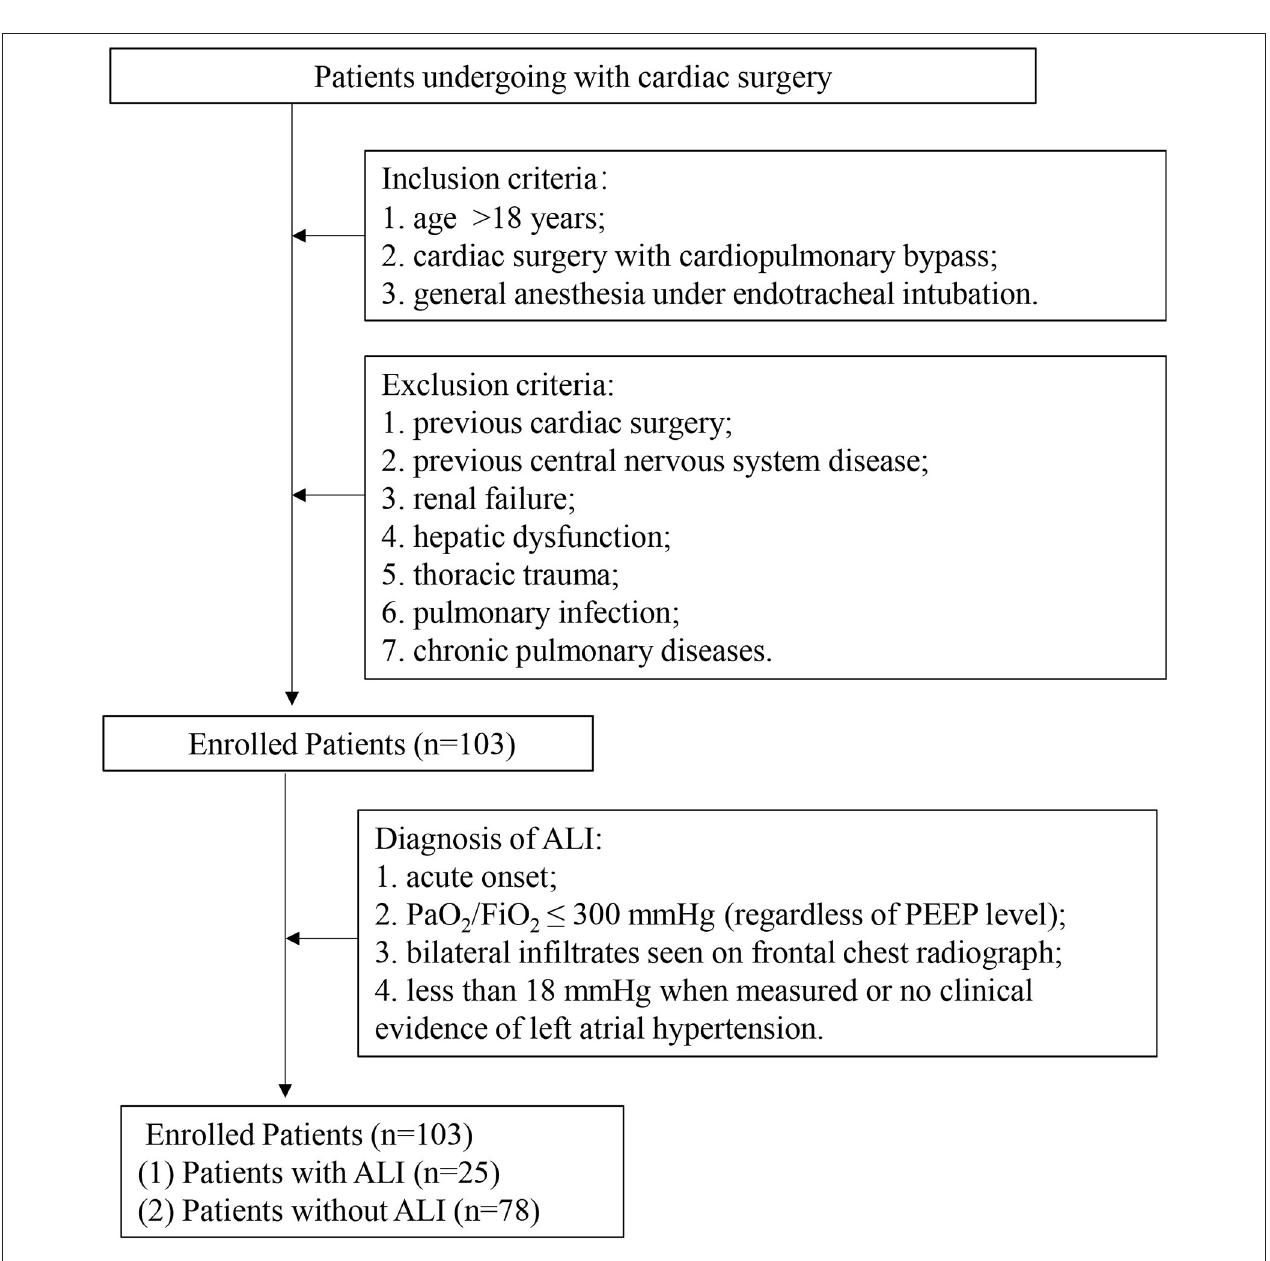
FIGURE 1 | Schematic flow chart of the study design. ALI: acute lung injury; PaO 2 , partial pressure of oxygen; FiO 2 , fraction of inspiration O 2 and PEEP, positive end-expiratory pressure.